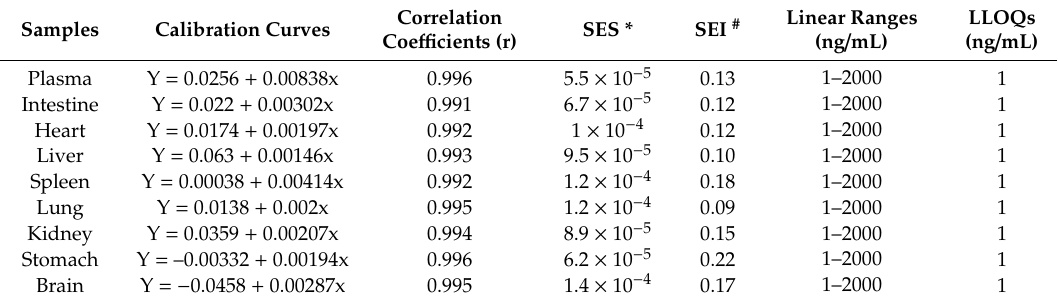
Table 1. Calibration curves, correlation coe ffi cients, linear ranges and lower limit of the quantification (LLOQ) of alnustone in di ff erent biological matrices.